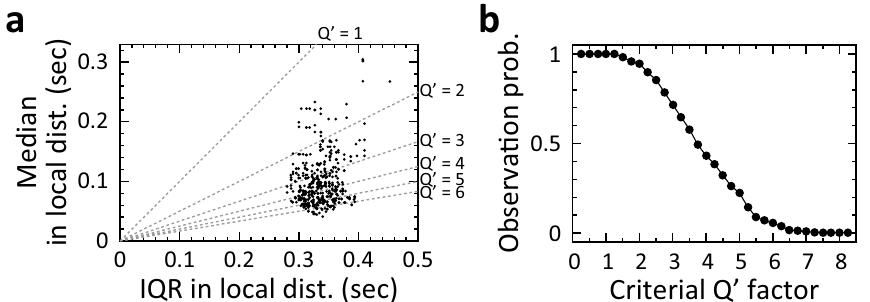
Figure 4. Calculation of the probability of observing a local distribution in which local Q ʹ factor exceeds a local Q ʹ factor threshold in a daily session. ( a ) Scatter plot of median and interquartile range (IQR) measured in each local distribution of action times in the same ‘short’ trials on Day 15 shown in Fig. 2a. The dashed line indicates median and IQR to be the local Q ʹ factor. ( b ) Probabilities to observe a local distribution of which local Q ʹ factor exceeds the local Q ʹ factor threshold in the same daily session are shown in ( a ). The probability was calculated at 0.25 steps of local Q ʹ factor